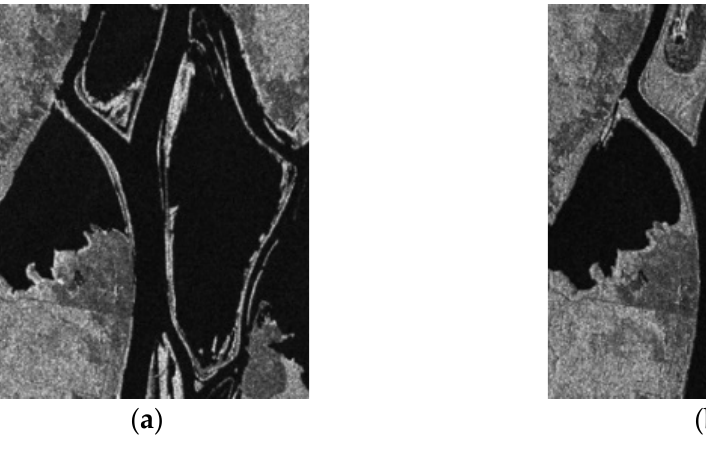
Figure 11. The Ottawa data: ( a ) May 1997 and ( b ) August 1997.